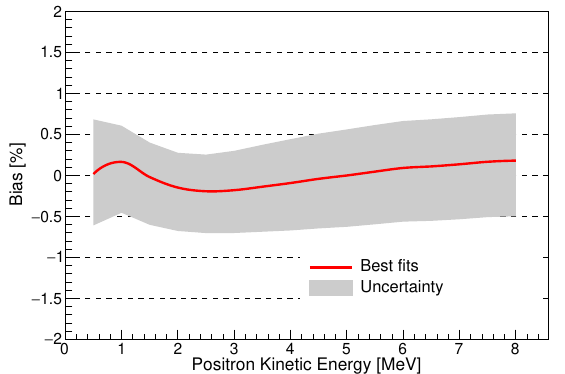
Figure 2 . Bias ( E e + − E e + ) /E e + in the reconstructed positron kinetic energy as a function of rec true energy. The shape of the bias is an artifact that the degree-of-freedom of the fit function does not describe perfectly the true non-linearity curve. The band represents the uncertainties in the calibration procedure, detailed in section 2.3.7. The lowest kinetic energy in the figure is 0.5 MeV, to avoid artificial increase of the fractional bias when the kinetic energy approaches